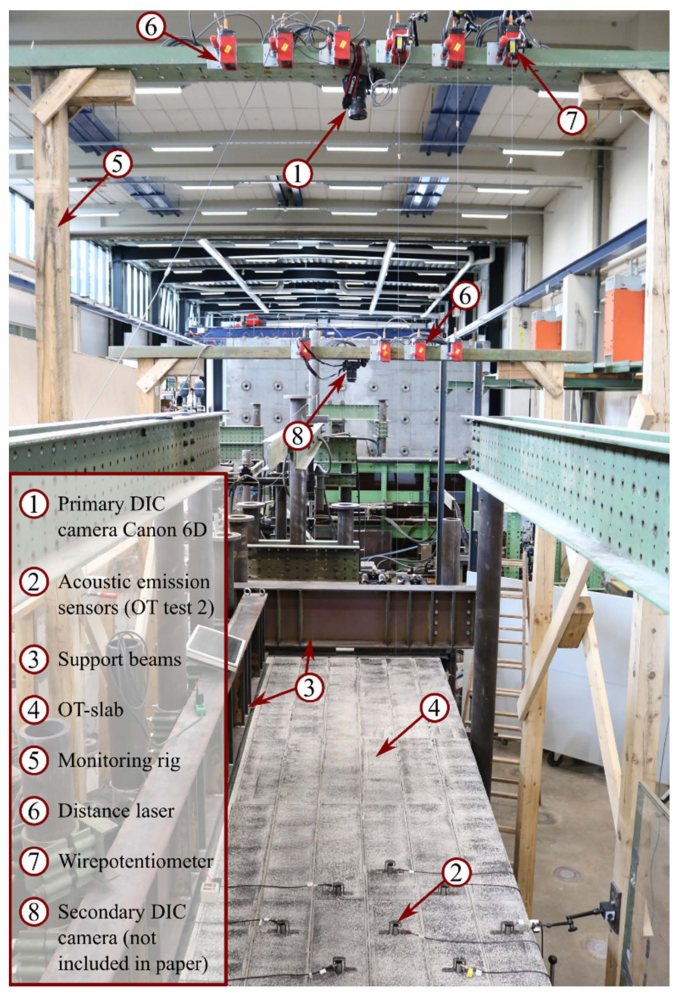
Figure 5. Test setup and monitoring